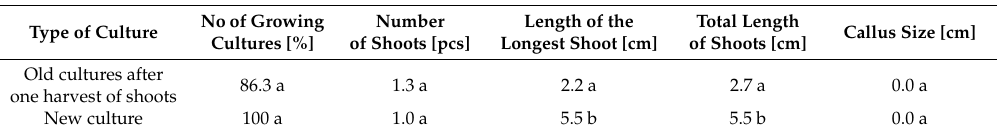
Figure 6. Comparison of the regrowth of axillary shoots in old cultures after the first harvest of shoots (left jar) with newly established “SNC” subculture (right jar). Both cultures of mountain mulberry ‘Kenmochi’ were grown on cytokinin-free media. Old cultures after 12 weeks of growth and 6 weeks after first harvest. New cultures after 6 weeks of growth. Table4. Regrowthofaxillaryshootsofmountainmulberry‘Kenmochi’in vitroculturesoncytokinin-free (SNC)